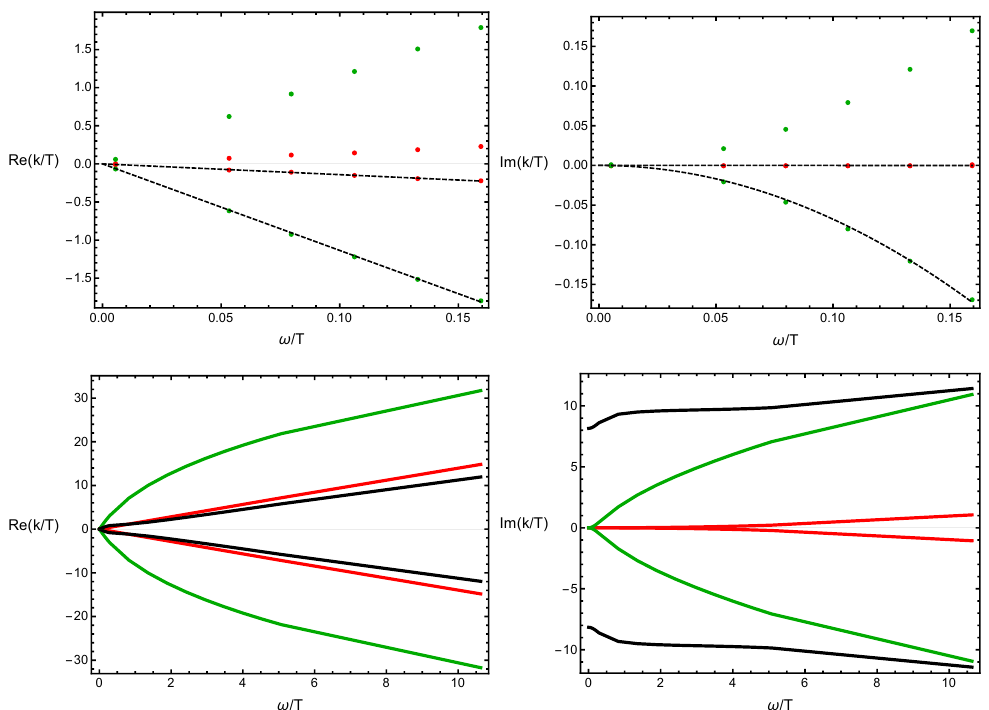
Figure 11 . The three lowest modes in the superfluid phase. The temperature is fixed at T/µ = 0 . 019 ( T/T = 0 . 92 ). Second sound (green), first sound (red), the former damped diffusive mode c (black). The dashed lines in the top panel show the expectation from eq. (5.3).